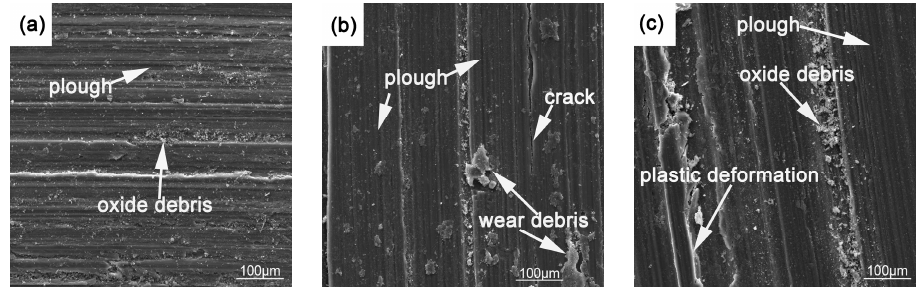
Figure 14. SEM images of worn surface for AZ91-1.0%Pr alloy under different applied loads ( a ) 30 N,